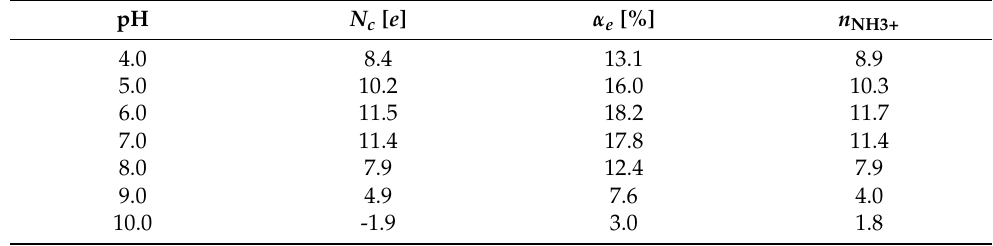
Table 4. Effective charge ( N c ), degree of ionization ( α ), and a number of ionized surface groups ( n NH3+ ) for an aqueous solution of G4PAMAM dendrimer as a function of